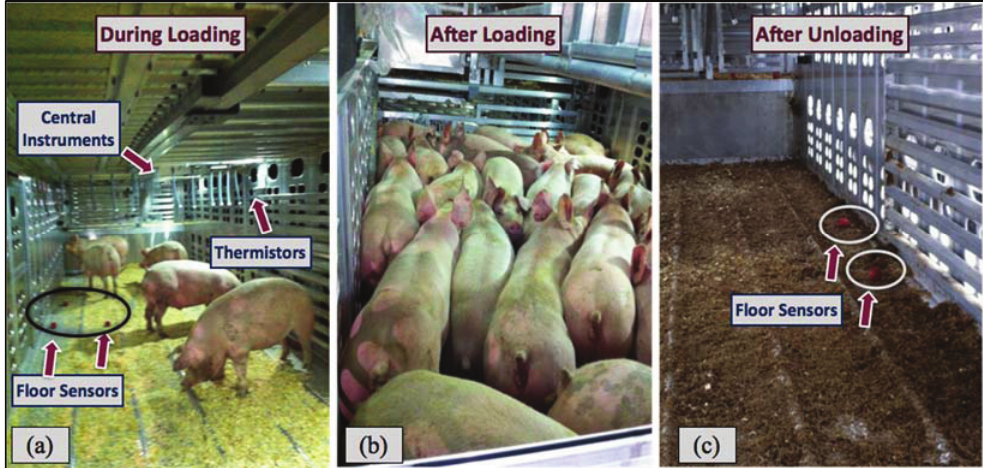
Figure 2. Trailer interior conditions with sensors deployed and pigs on the trailer: ( a ) during loading; ( b ) after loading, before transport; and ( c ) after